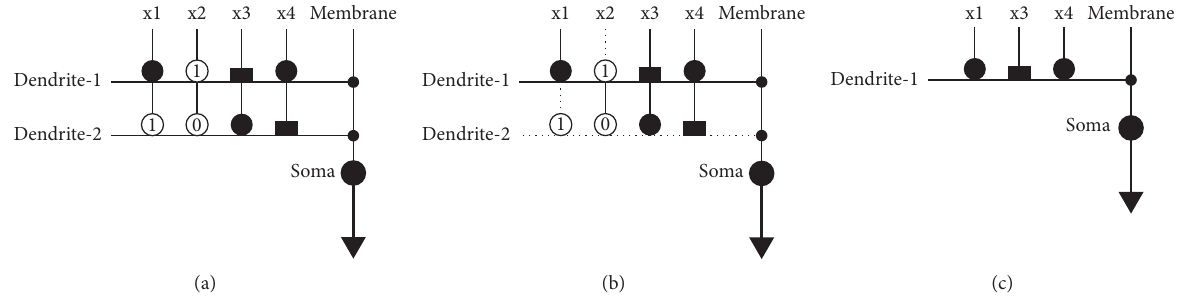
Figure 4: An example of neural model pruning process.